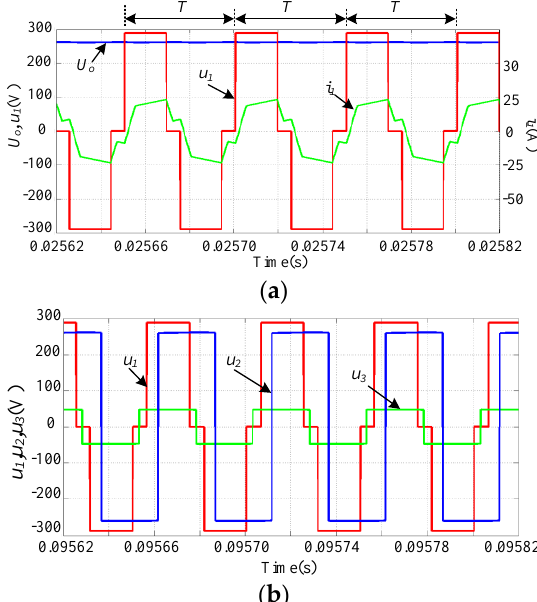
Figure 18. Simulated waveforms of phase-shifted PWM control with fixed switching-frequency: ( a ) converter voltage, current of port 1 and output voltage of port 2; ( b ) converter voltages of port 1, 2 and 3.